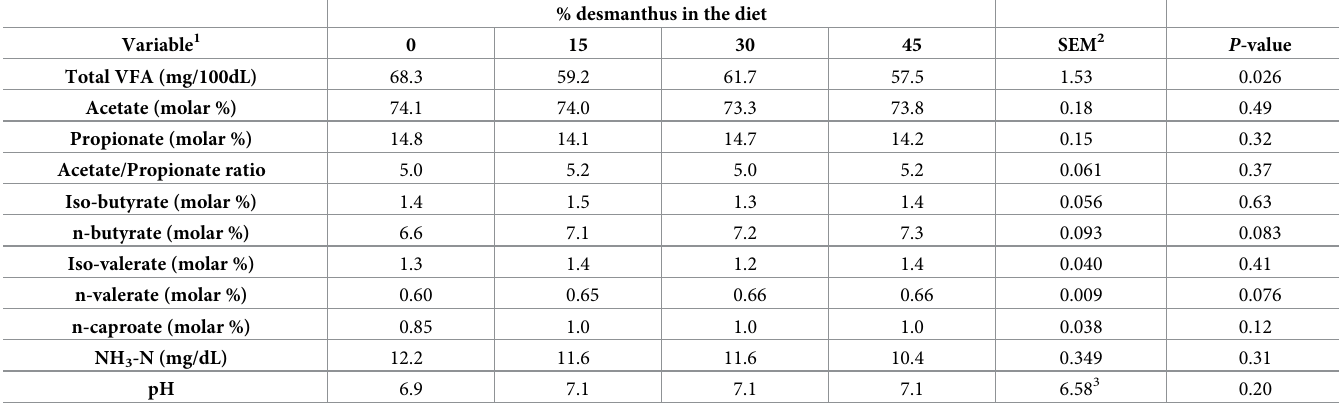
Table 6. Rumen volatile fatty acids (VFA), ammonia nitrogen (NH3-N) and pH of tropical beef cattle fed increasing levels of desmanthus. % desmanthus in the diet